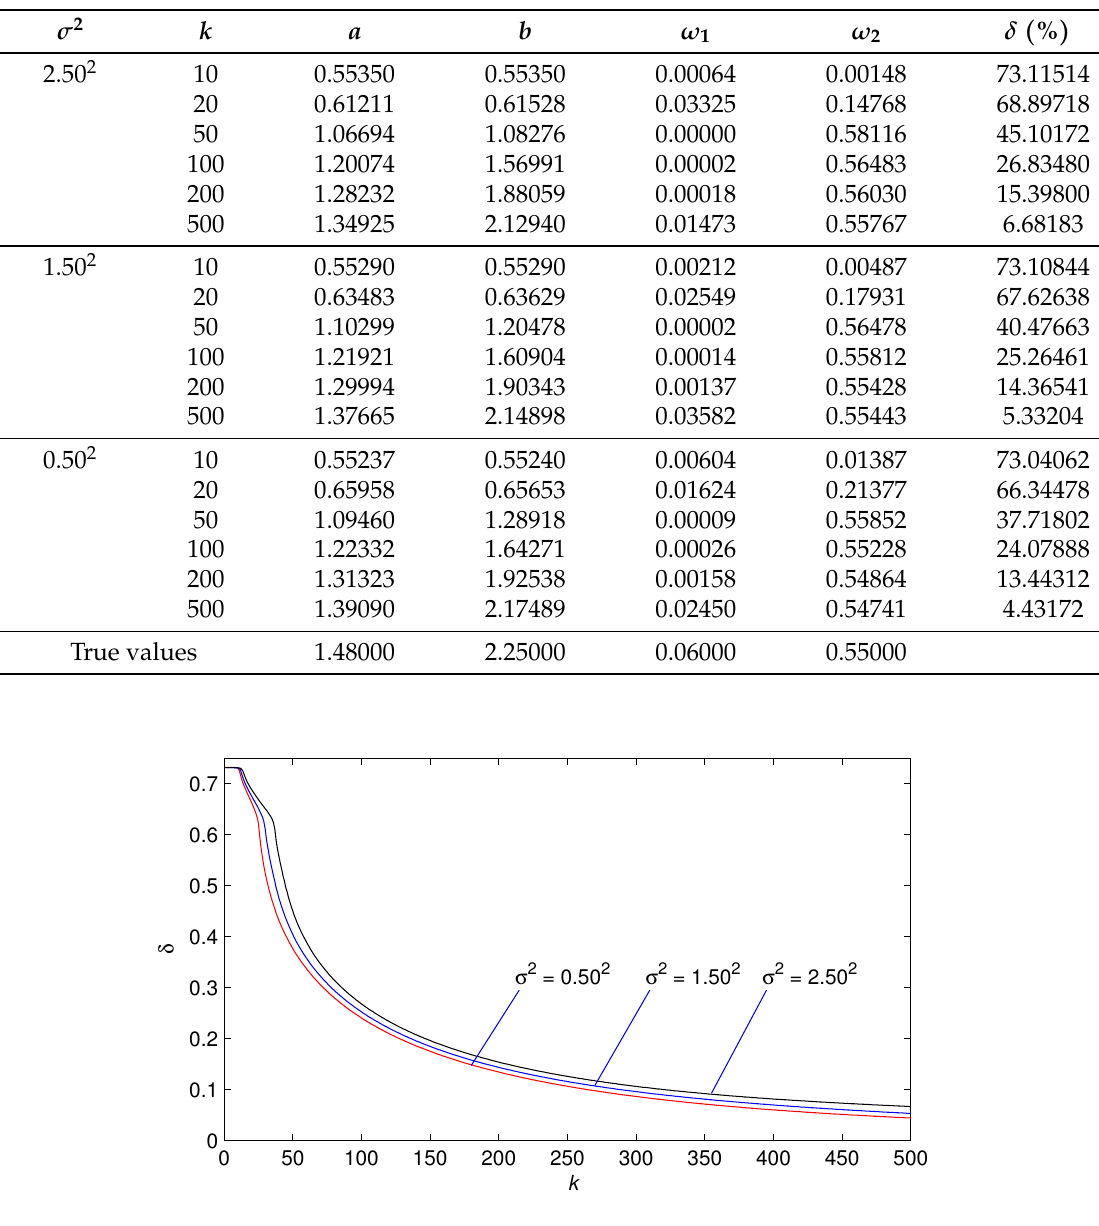
Figure 1. The GI estimation errors δ versus k